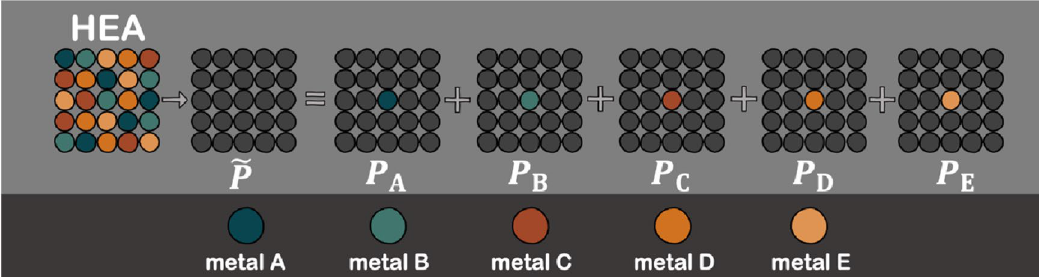
Figure 1. The coherent potential approximation (CPA) for the penta-metallic high-entropy alloy (HEA) recreated from Tian et al. 53